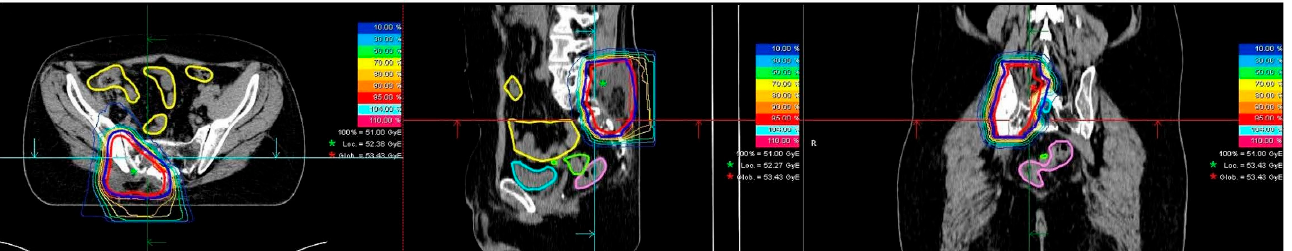
Figure 2. Example of a patient with locally recurrent pelvic Ewing sarcoma undergoing carbon ion radiotherapy.